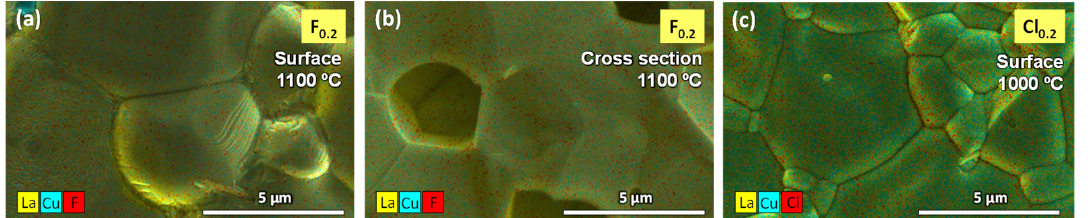
Figure 5. SEM - EDS analysis of ( a ) surface and ( b ) cross-section of F 0.2 sintered at 1100 °C for 1 h. SEM-EDS analysis of the surface of ( c ) Cl 0.2 sintered at 1000 for 1 h.